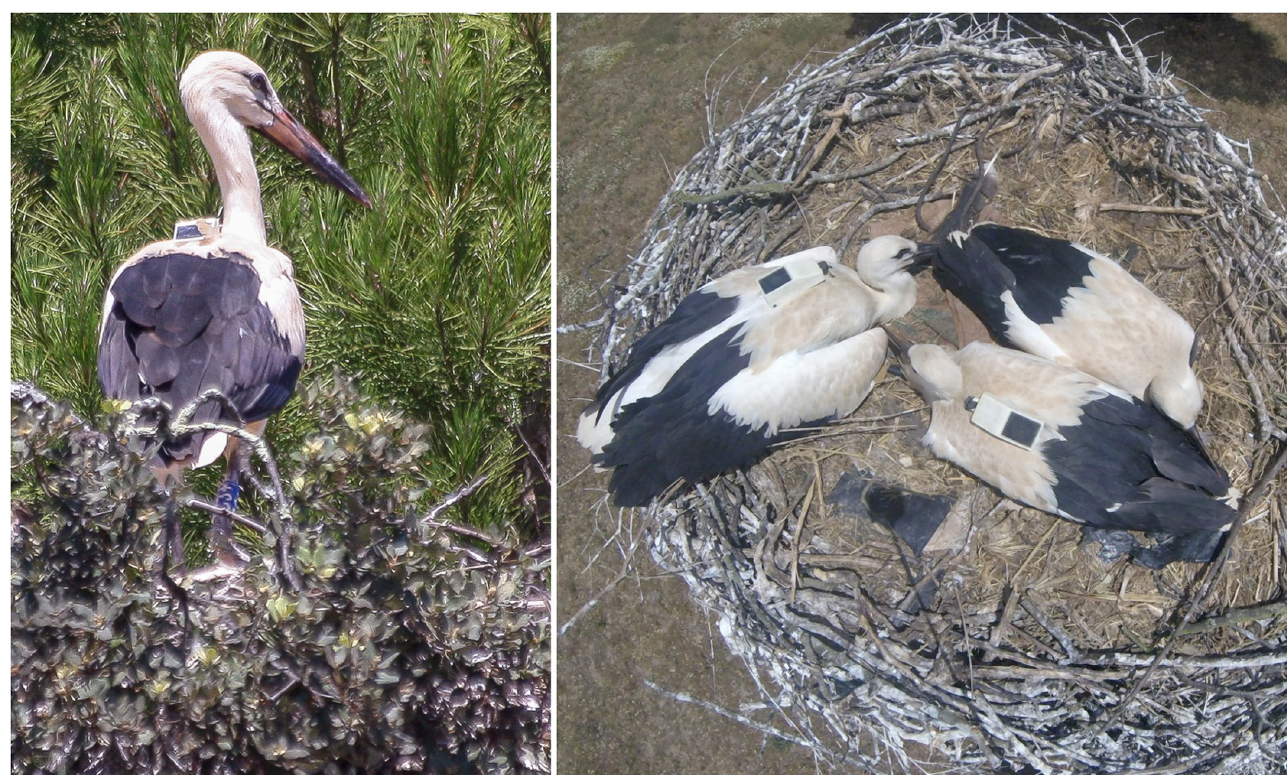
Fig 5. Position of the tracking devices on the back of pre-fledging white